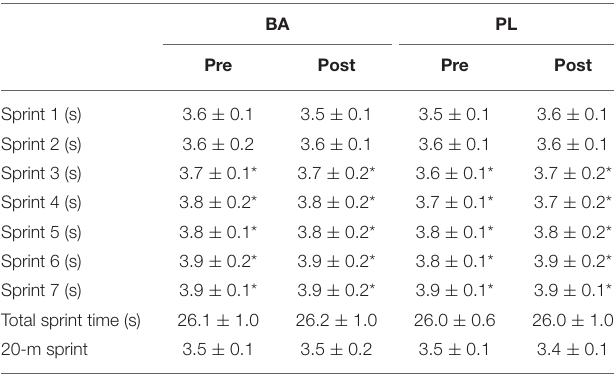
TABLE 1 | Sprint times (s) during the RAST for the beta-alanine (BA) and placebo (PL) groups pre- and post-supplementation. BA PL Pre Post Pre Post